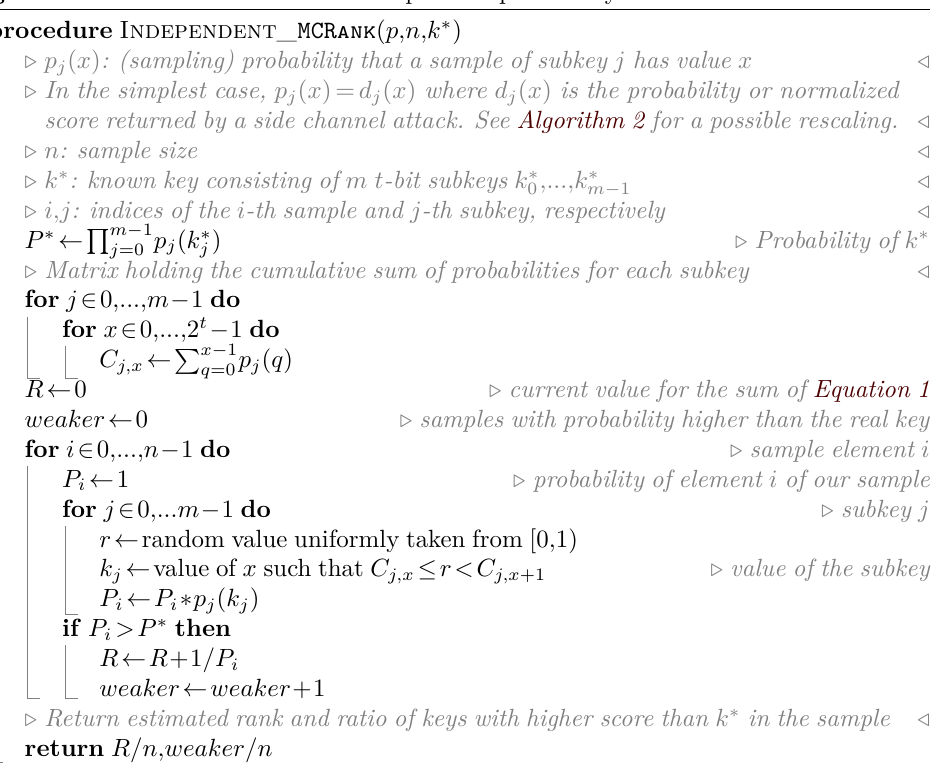
Algorithm 1 Rank estimation with independent probability distributions procedure Independent_ MCRank ( p,n,k ∗